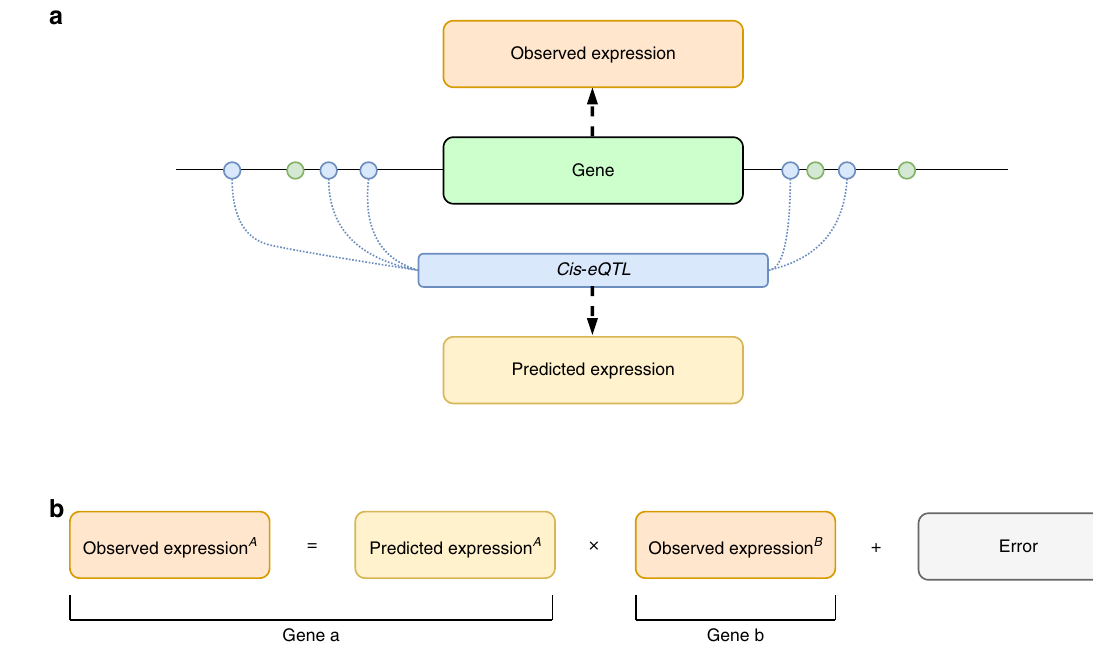
Fig. 1 Employing a gene ’ s cis - eQTL complement to identify genetic interactions. a SNPs within 1 Mb of a gene ’ s transcription start and termination sites were used to train an expression level prediction model using PredictDB. Predictions from these models correspond to the additive effect of all cis- regulatory variants for a given gene. b The observed expression of gene A can then be modelled as an interaction (X) between its cis - eQTL (predicted expression) and the observed expression of other genes in the genome (gene B ). The error term represents, for example, uncaptured environmental or trans effects linked to variation in the expression of gene A , not capture by these other